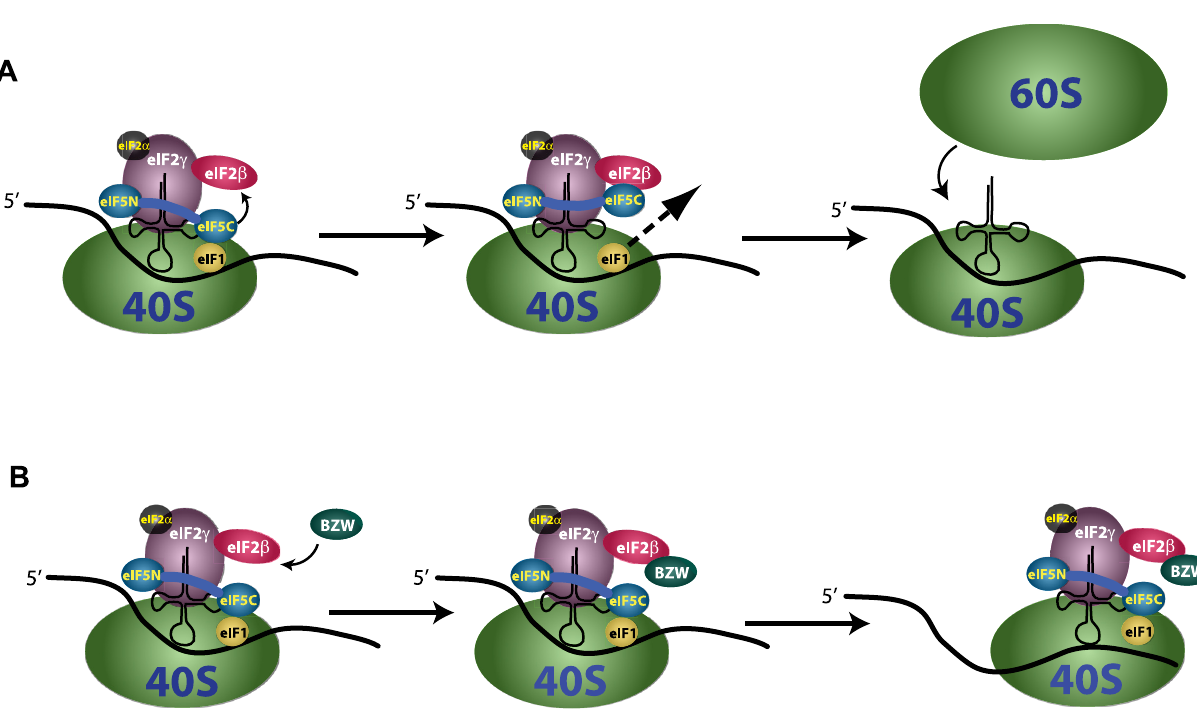
Fig 4. A model for the molecular interactions likely to account for the effect of BZW1 and BZW2 on stringency of start codon selection. During scanning, when the 40S subunit is in the open conformation, eIF1 is bound near the P-site and monitors the interaction between tRNA iMet and nucleotide triplets in the mRNA. The eIF5 C-terminal domain is loosely bound to eIF1 working as a lid to prevent the premature release of eIF1 from the PIC. (A) Under low BZW levels, the eIF2 β N-terminal domain and eIF5 C-terminal domain occasionally interact pulling eIF5 away from eIF1, allowing its looser association with the PIC. The lower affinity of eIF1 for the PIC facilitates more frequent initiation at near-cognate or suboptimal AUG codons. (B) BZW, perhaps through its C-terminal HEAT domain, binds to the eIF2 β N-terminal domain. When levels of BZW protein are high this interaction is favored, and this prevents interaction between eIF2 β and eIF5. This leaves the “lid” on eIF1 closed, essentially increasing its effective concentration on the PIC and this enhances stringency of start codon selection, resulting in lower frequency of initiation at near-cognate start codons or poor context AUG triplets, including the start codons of BZW genes, with ribosome continuing to scan in the 3’ direction for a better start codon.